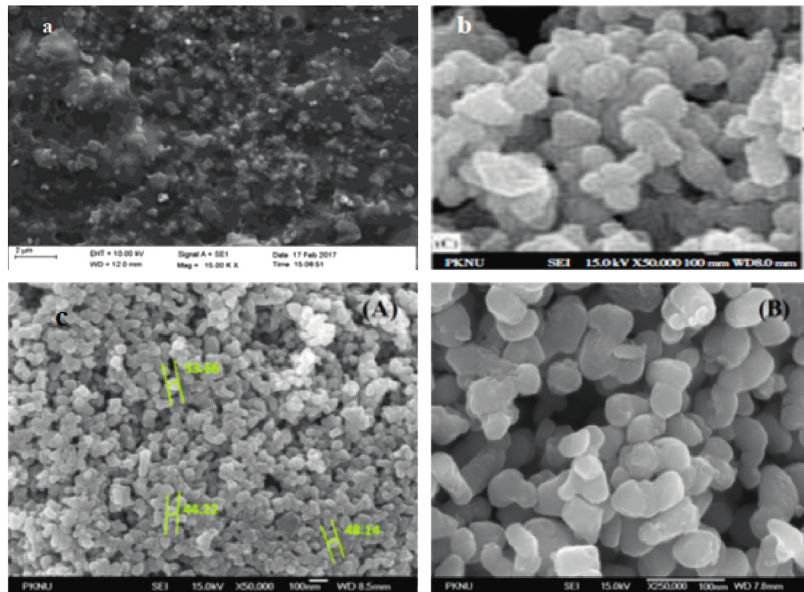
Figure 8: SEM image of (a) citrus lemon leaf, (b) psidium guajava , and (c) aeromonas hydrophila (A, 50000 × and B, 2500 × ) templated synthesis of TiO 2 NPs [43, 51,